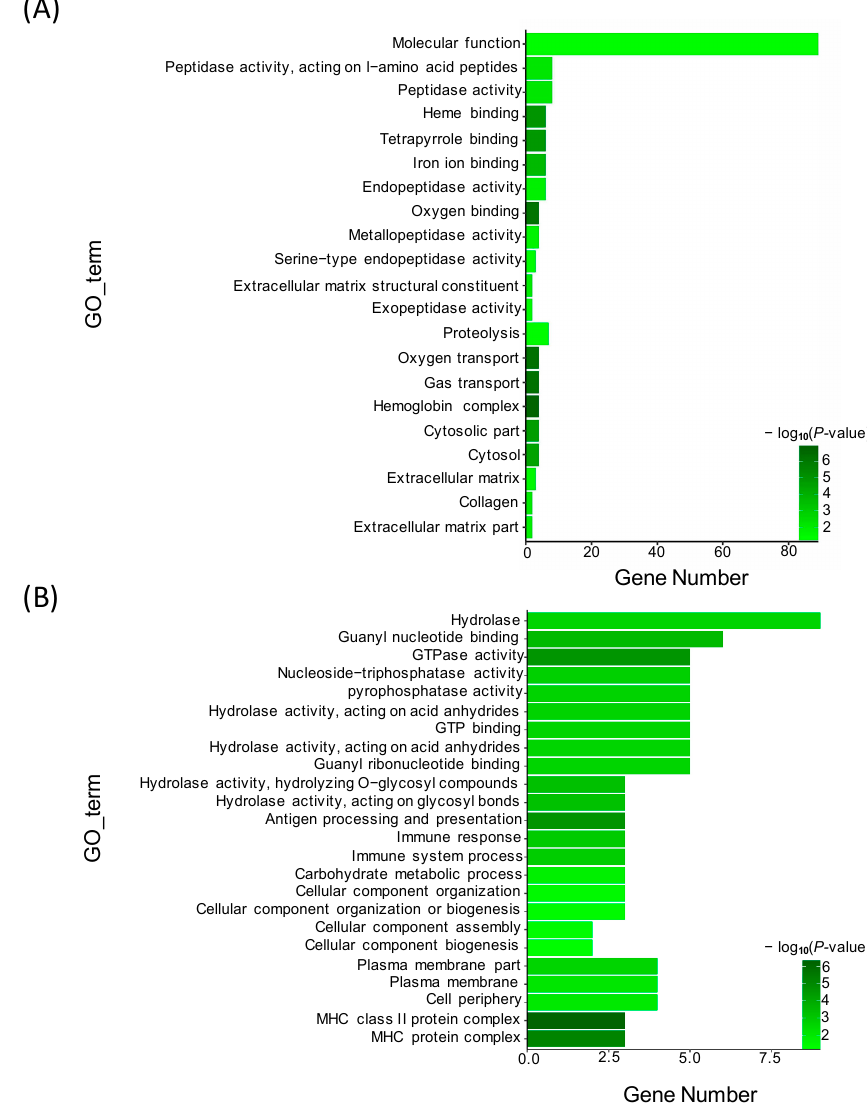
Figure 3. Gene ontology (GO) enrichment analysis of DE genes between TM and WT. ( A ) Significantly enriched GO terms of up-regulated DE genes; ( B ) Significantly enriched GO terms of down-regulated DE genes. DE